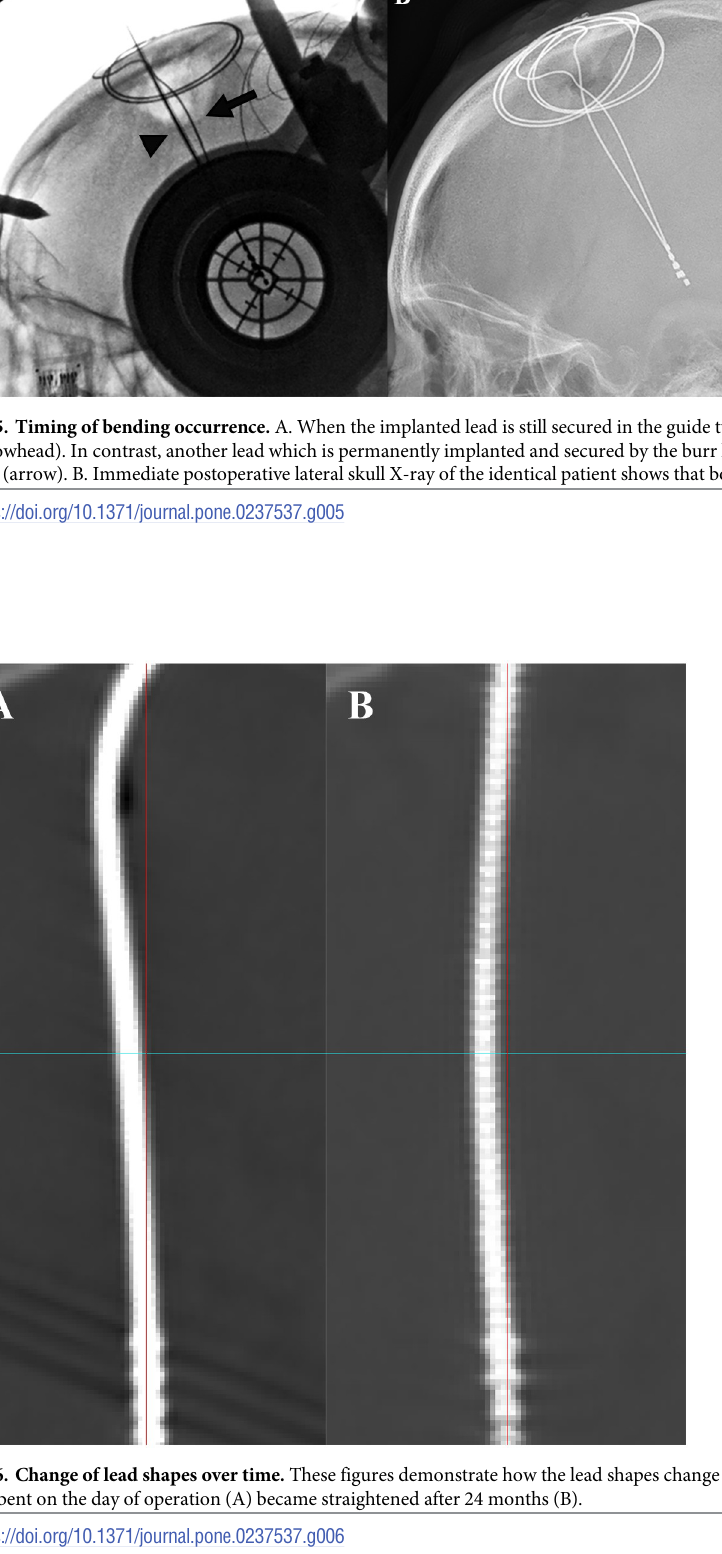
PLOS ONE | https://doi.org/10.1371/journal.pone.0237537 August 12,